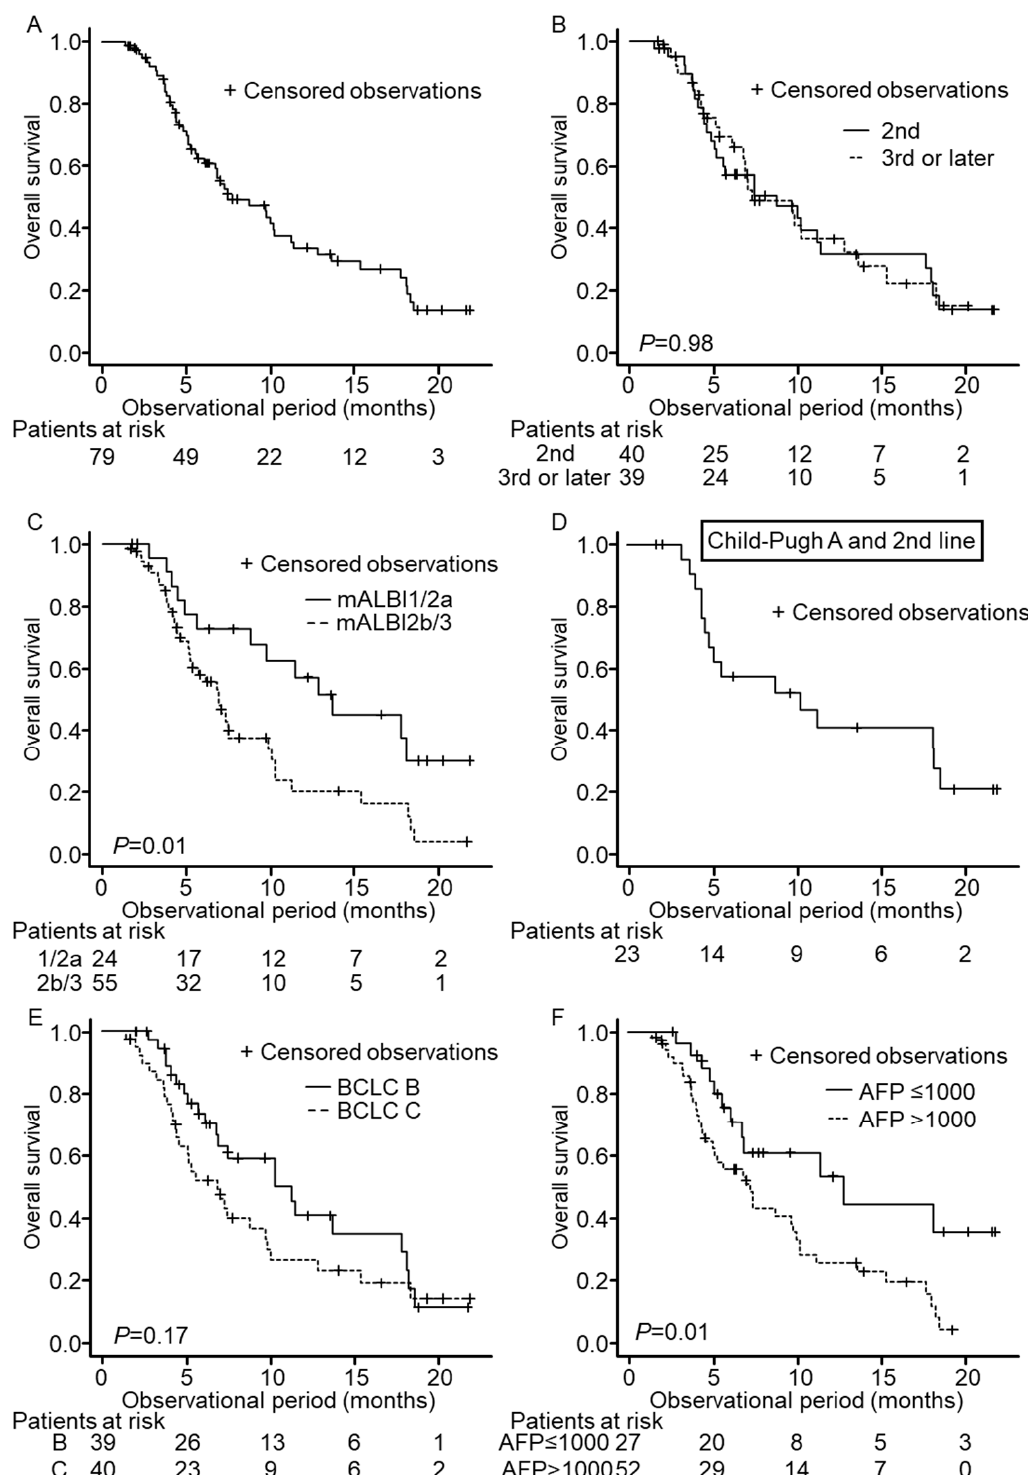
Figure 1. Overall survival (OS) of patients enrolled in this study. Censored observations are marked as + in each Kaplan–Meier curve. Each panel shows OS in the entire cohort ( A ), OS according to the treatment course of ramucirumab ( B ), mALBI grade ( C ), BCLC stage ( E ), and AFP level ( F ), respectively. Panel ( D ) shows OS in patients of 2nd-line treatment with Child–Pugh A.